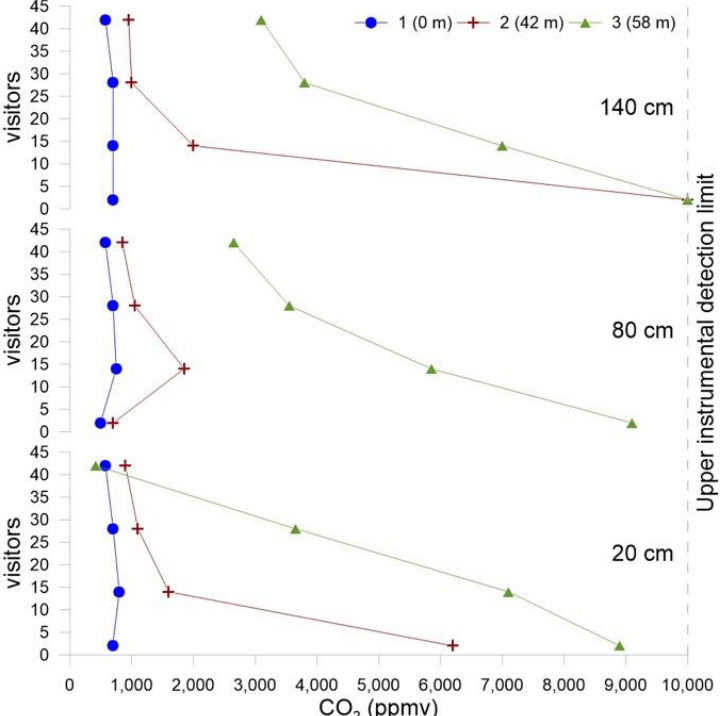
Figure 5. Air CO 2 concentrations measured inside Carburangeli cave during the 19 June 2000 experiment (modified from [14]). Progressive distances of the points from cave entrance are reported between round brackets (see also Figure 2 for point locations).